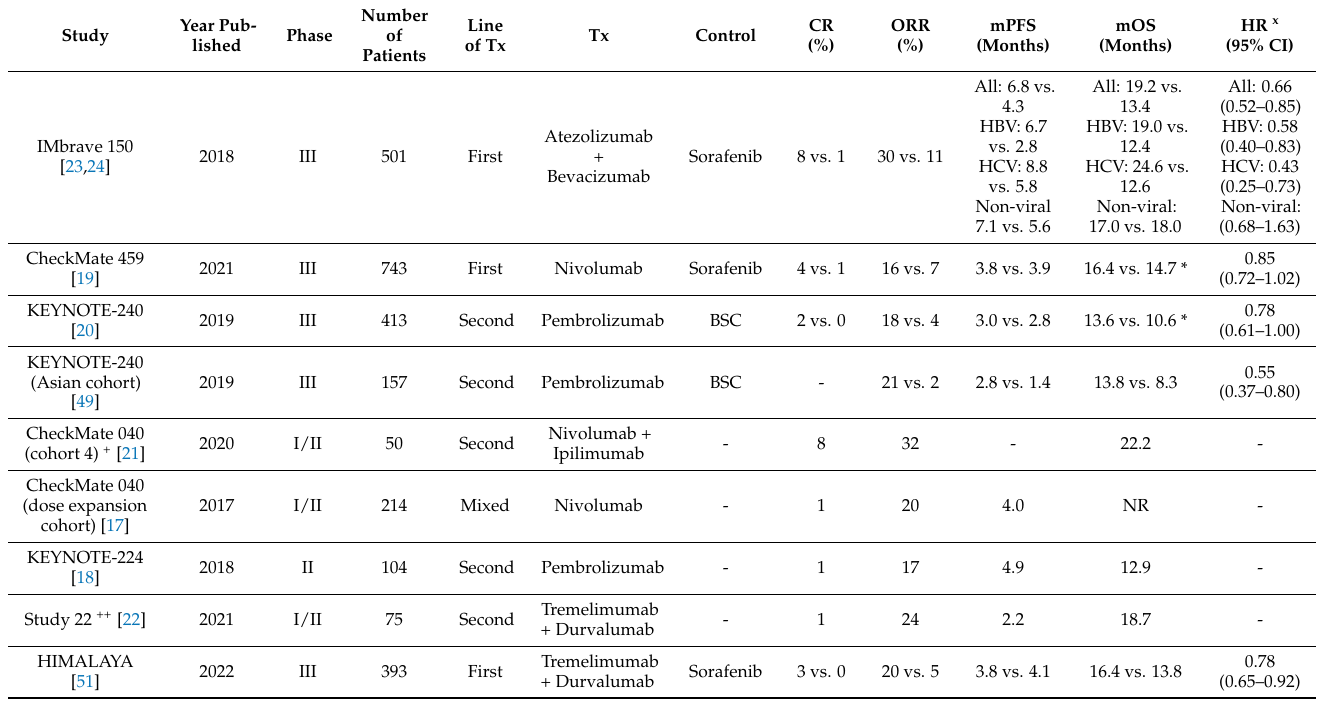
Table 2. Summary of main outcomes among systemic therapies (immunotherapy) approved for advanced